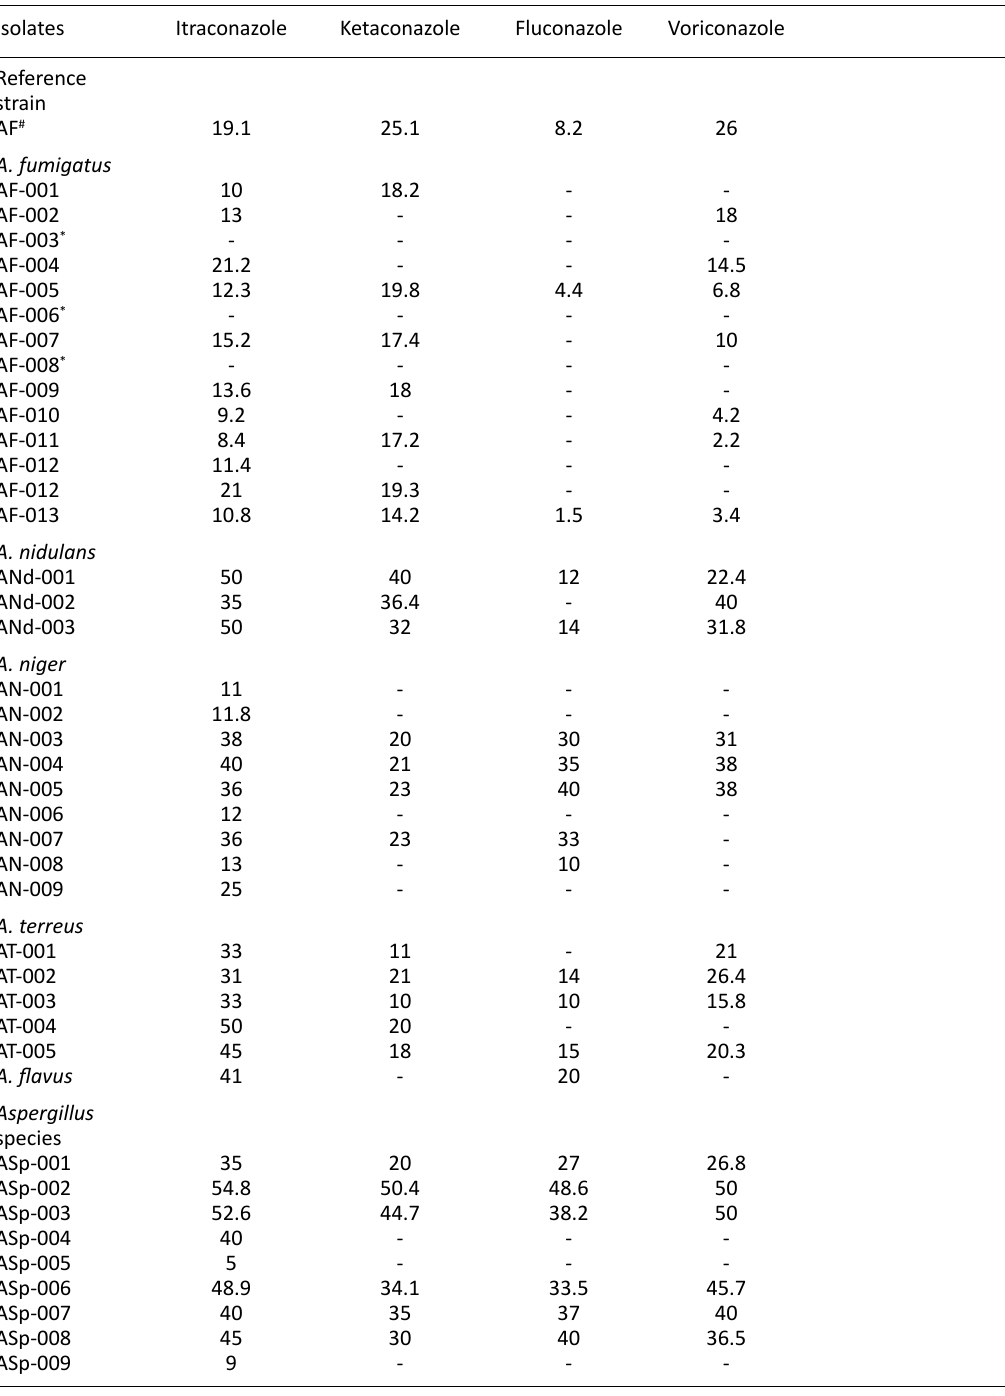
table 1. Zone of inhibition (in mm) of all Aspergillus isolates against tested azole antifungals